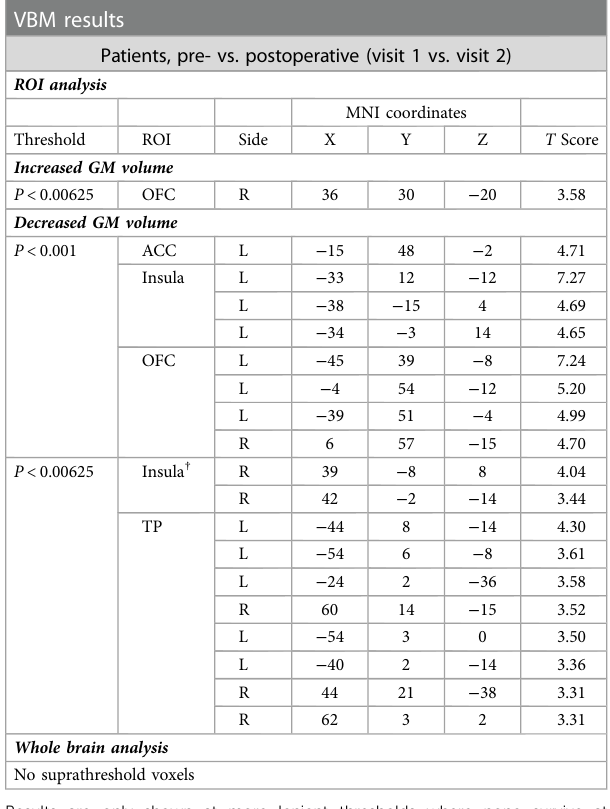
TABLE 3B Voxels of signi fi cant change in GM volume after surgery, within patient group (visit 1 vs. 2). VBM results Patients, pre- vs. postoperative (visit 1 vs. visit 2) ROI analysis